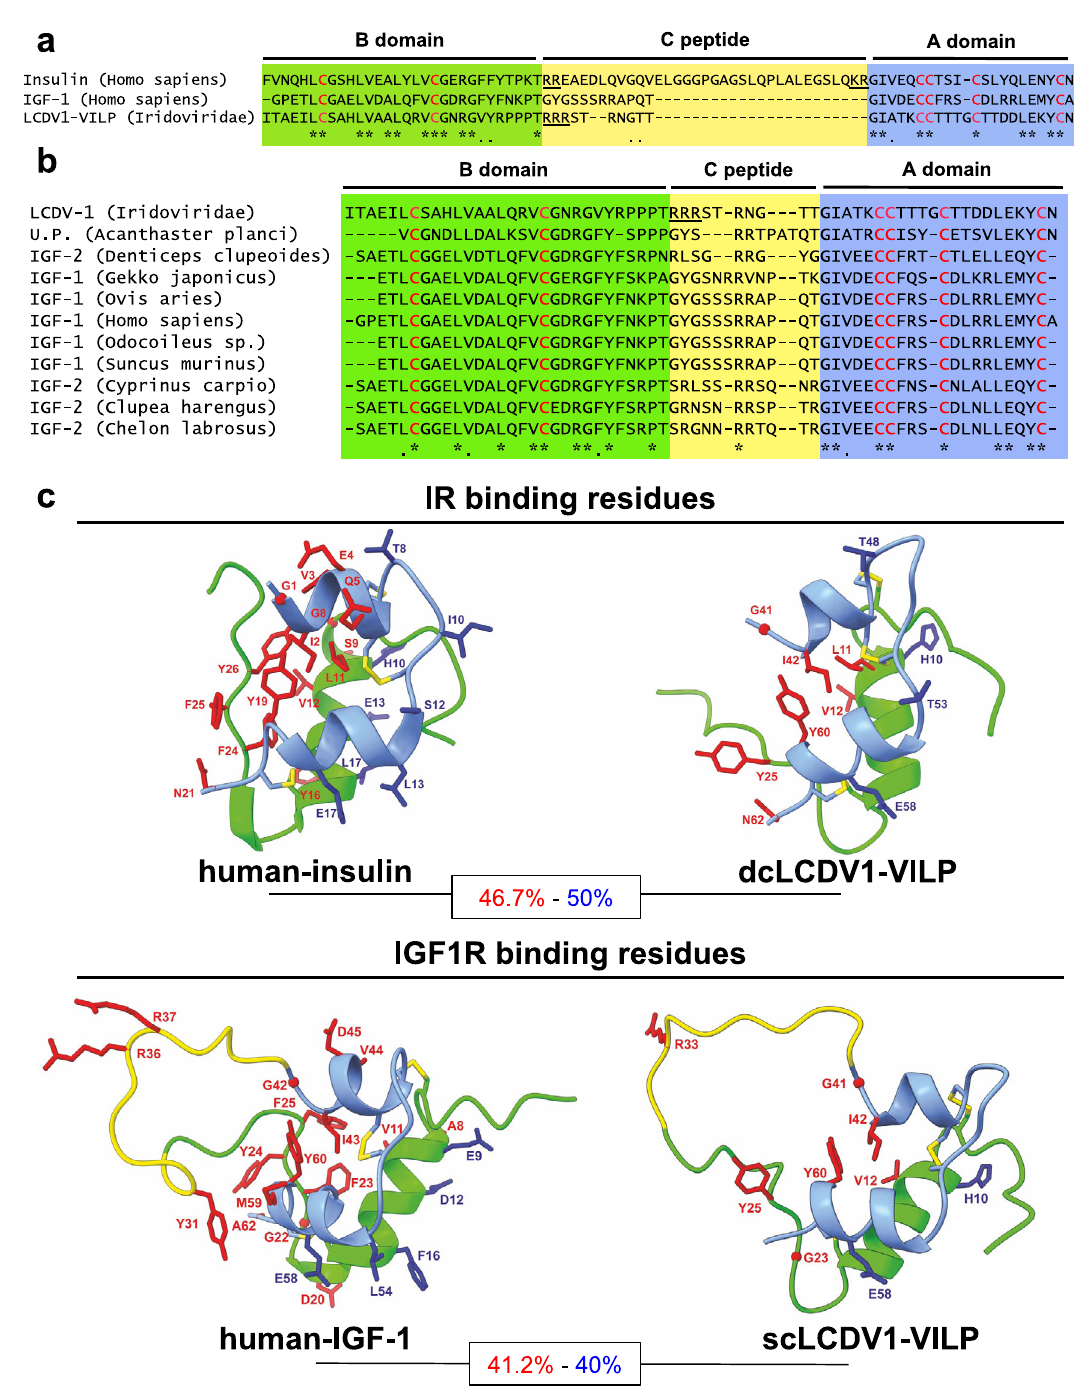
Fig. 1 | Structural homology of LCDV1-VILP with insulin and IGFs. a Sequence alignment of LCDV1-VILP with the human insulin and IGF-1. Strictly conserved cysteine residues are in red. The yellow square represents the C-domain, while the A- and the B-domains are in blue and green respectively. Cleavage sites composed of dibasic residues are underlined. Conserved amino acids are represented by an asterisk (*), and conservatively substituted residues are noted as a dot (.). b The LCDV1-VILP sequence was aligned with the 10 sequences showing the highest sequenceidentity. c Three-dimensionalrepresentation of insulin (PDB:3I40),IGF-1